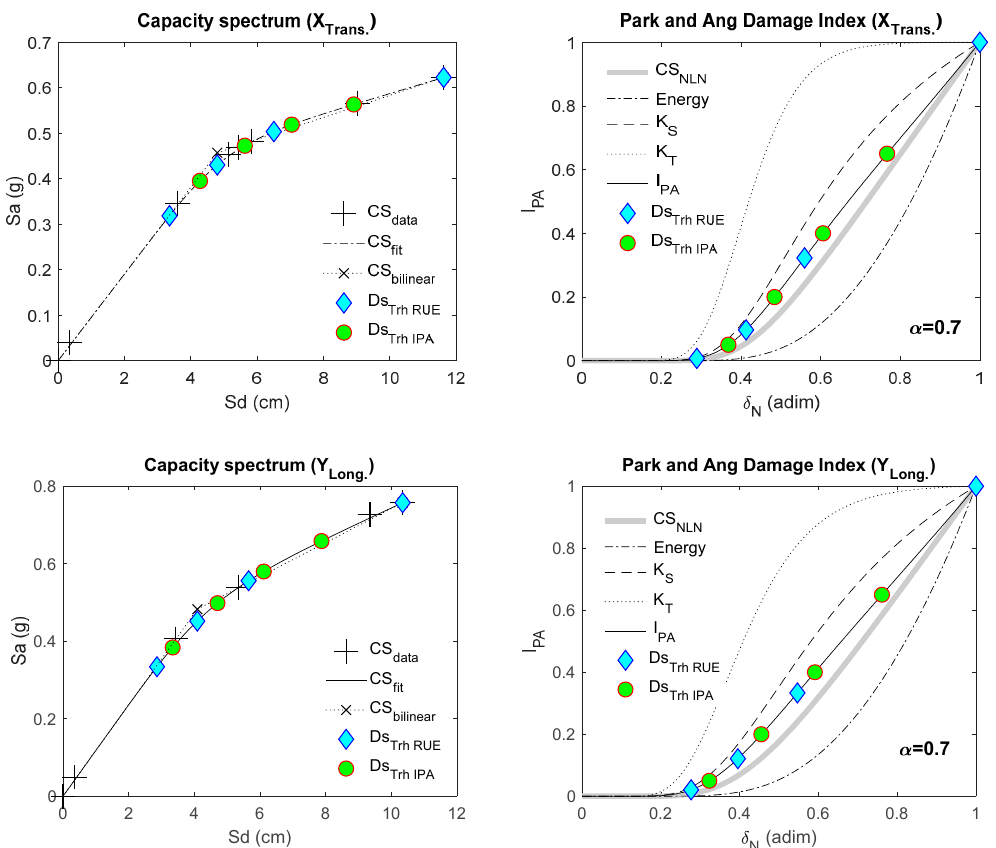
Figure 11. Capacity spectra ( left ) and damage functions ( right ) for: X direction and Y direction. Bilinear forms of capacity spectra and thresholds of damage states based on the Risk-UE project ( Ds Trh RUE ) and those based on the Park and Ang damage index ( Ds Trh IPA ) are shown. See also the explanations in the text.